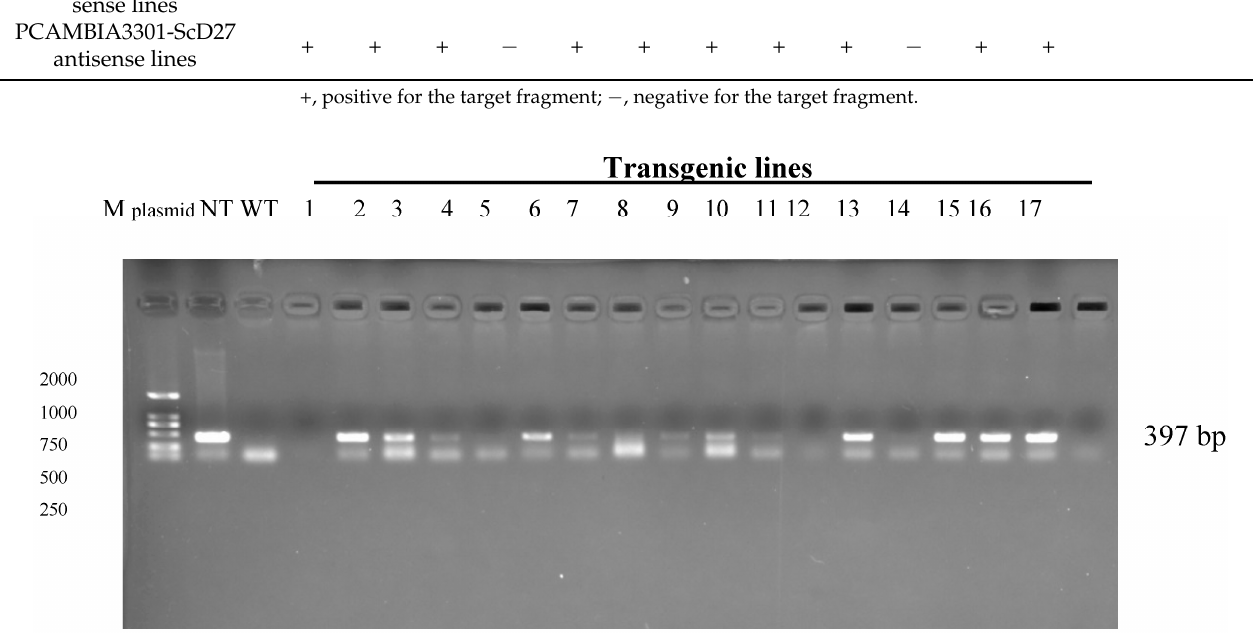
Figure 2. PCR detection of the Bar gene in transformed seedlings. M, Marker; NT, Non-transgenetic lines; WT, Wild type.